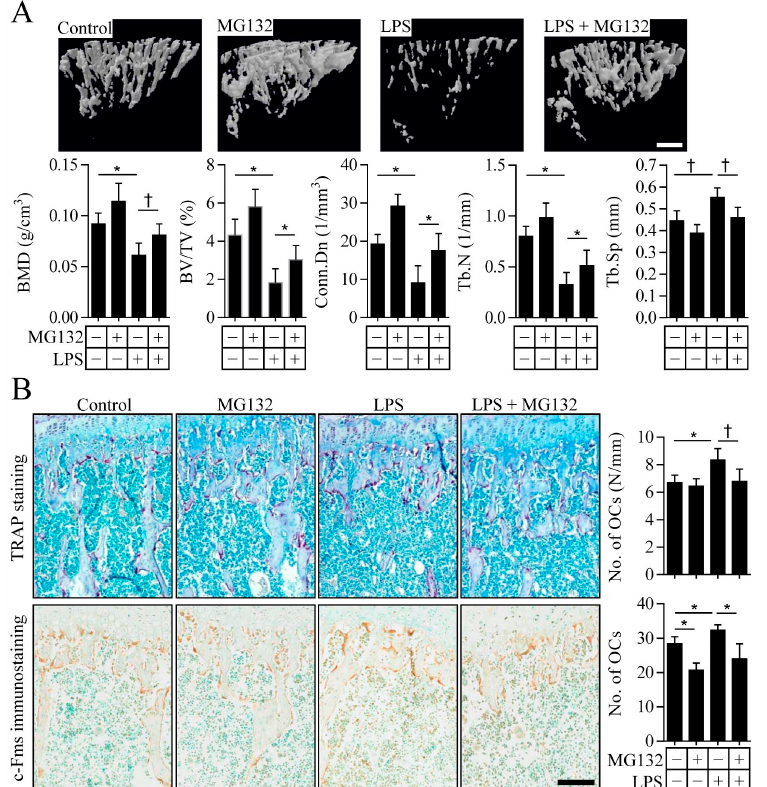
Figure 5. MG132 inhibits LPS-induced osteoporotic bone loss in mice. ( A ) Representative μ CT images of tibial trabecular bone, as well as bone loss indices, were analysed in mice injected intraperitoneally with MG132 and/or LPS. Quantitative data for trabecular structural parameters are also shown as means ± SD ( n = 7 mice per group). Scale bar, 10 μ m; ( B ) tibial sections from mice treated as in ( A ) were stained with TRAP (upper images) to detect osteoclasts and subjected to immunohistochemistry to visualize c-Fms-positive osteoclasts (lower images). The number of osteoclasts per millimeter of trabecular bone surface and the number of c-Fms-positive osteoclasts in a defined trabecular bone area were counted. All quantitative data are presented as means ± SD ( n = 7) * p < 0.01, † p < 0.05. Scale bar, 200 μ m.